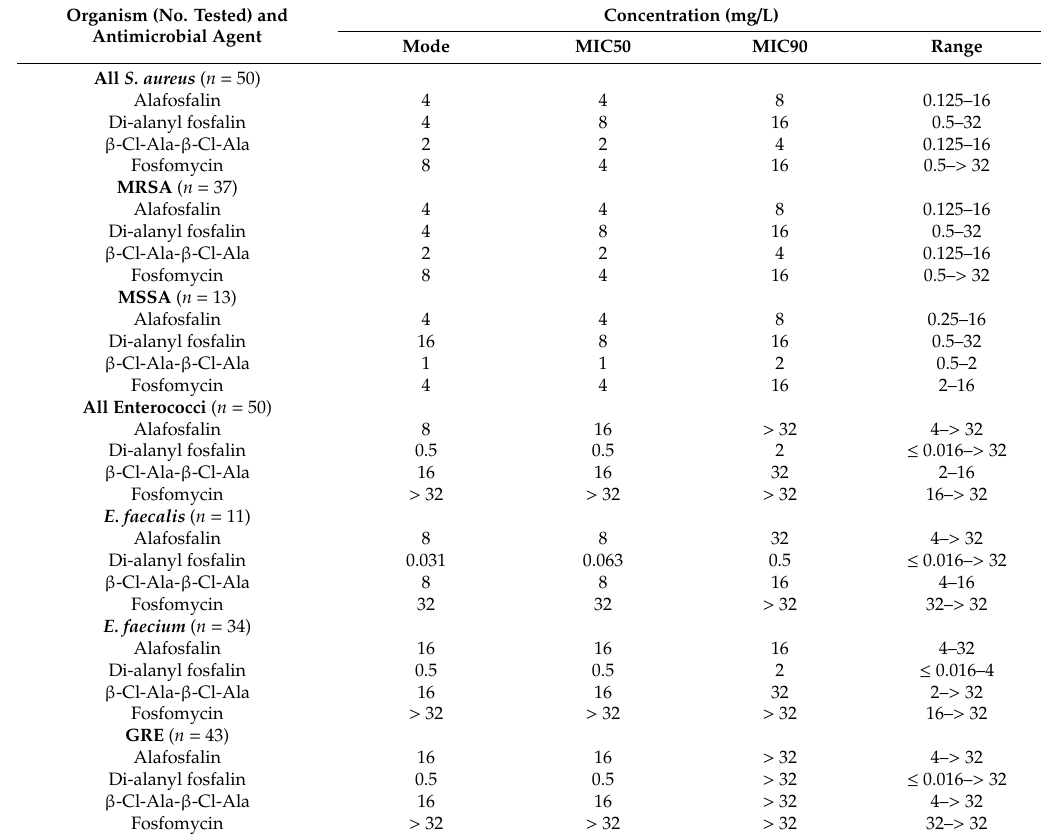
Table 2. Minimum inhibitory concentrations of various antimicrobial agents against groups of Gram-positive bacteria including isolates with defined resistance